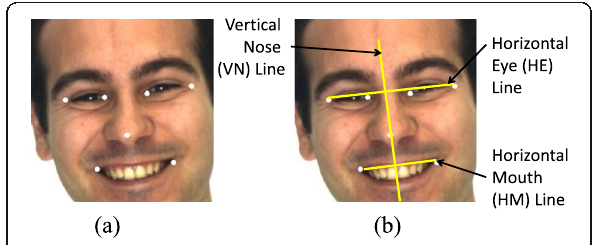
Fig. 7 Facial image with a seven landmarks retrieved by the face alignment method and b three fitting (HE, HM, and VN) lines obtained by the least square